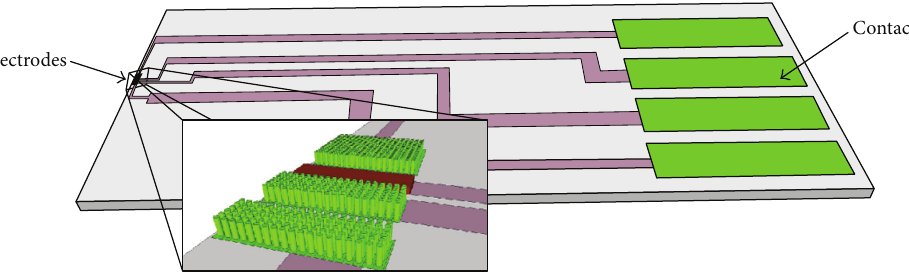
Figure 1: Patterned electrochemical sensor design with contact pads.